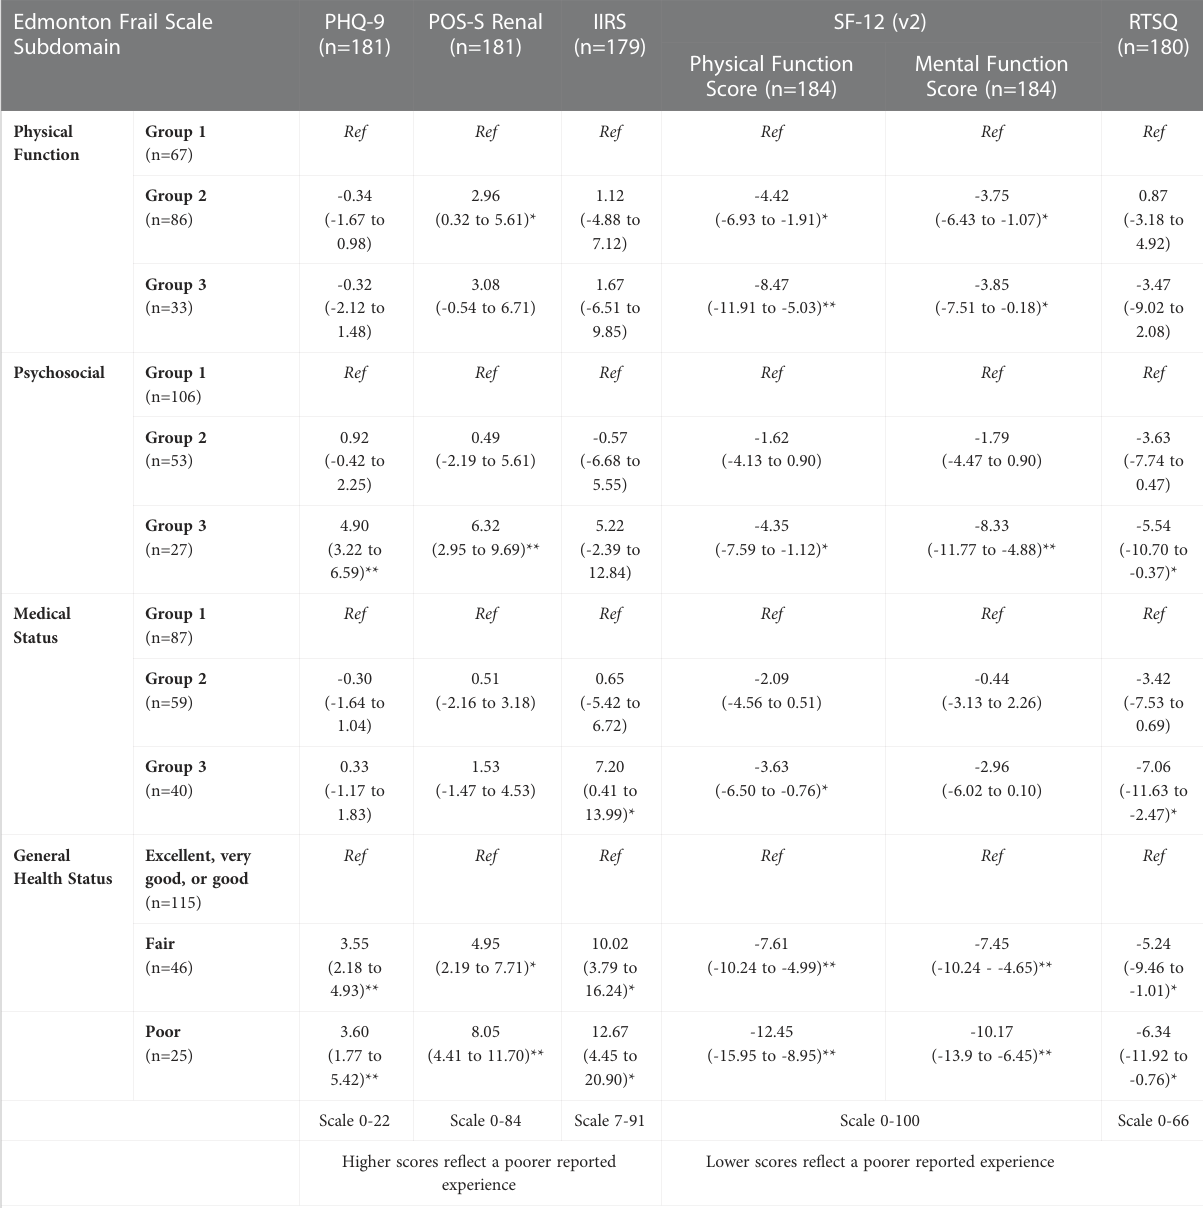
TABLE 4 Patient experience scores and their variation by edmonton frail scale subdomains. Edmonton Frail